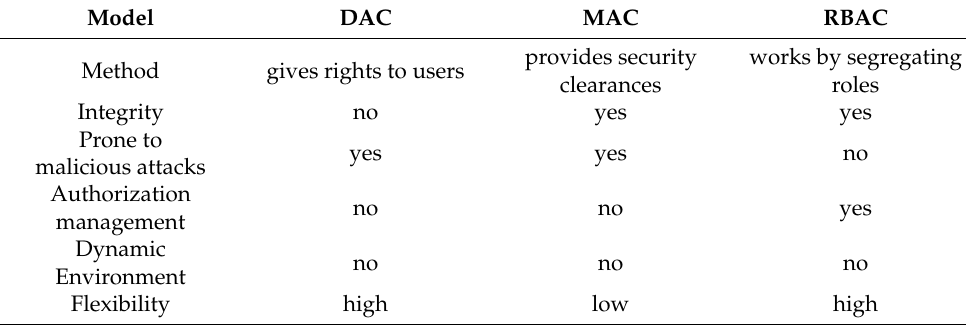
Table 1. Comparison of different access management policy